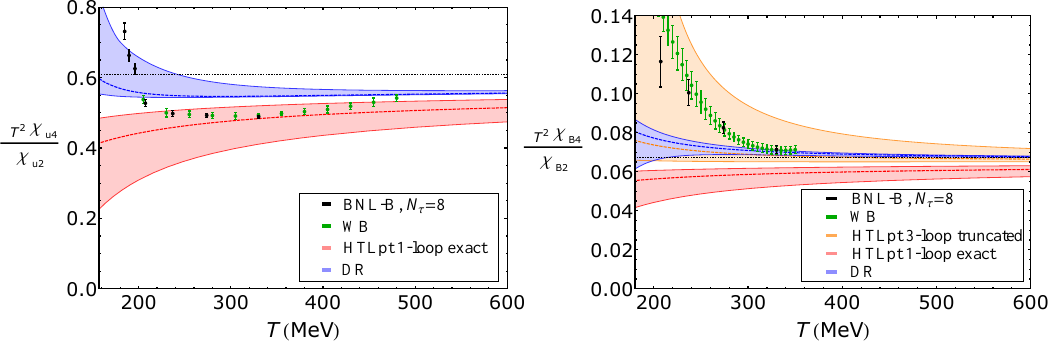
Figure 3. Ratios of low order susceptibilities for the quark ( left ) and baryon ( right ) numbers. The lattice data is from [40,41] (BNL–B) and [43,45] (WB). The three-loop HTLpt result is obtained from the corresponding cumulants of [37]. The black dashed (straight) lines denote the Stefan Boltzmann